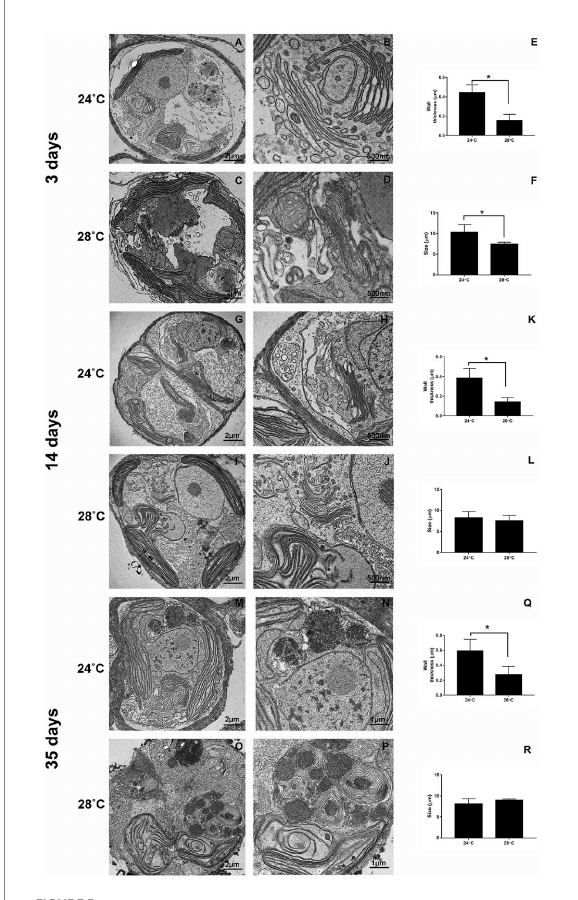
FIGURE 5 Ultrastructural changes during heat stress in Cladocopium cells. TEM micrographs showing Cladocopium cells cultured at 3 days were demonstrated in panels A and B (24°C) and C and D (28°C), 14 days- Panels G and H (24°C) and I and J (28°C), and 35 days- Panels M and N (24°C) and O and P (28°C). Cladocopium Wall thickness ( E , K , and Q ) and Size ( F , L , and R ) were represented in graphs. Abbreviations: LD, or * lipid droplet; Ch, chloroplast; Pyr, pyrenoids; N, nucleolus; W, wall; AC, Accumulation body; GC, Golgi Complex. The scale bars indicate in the